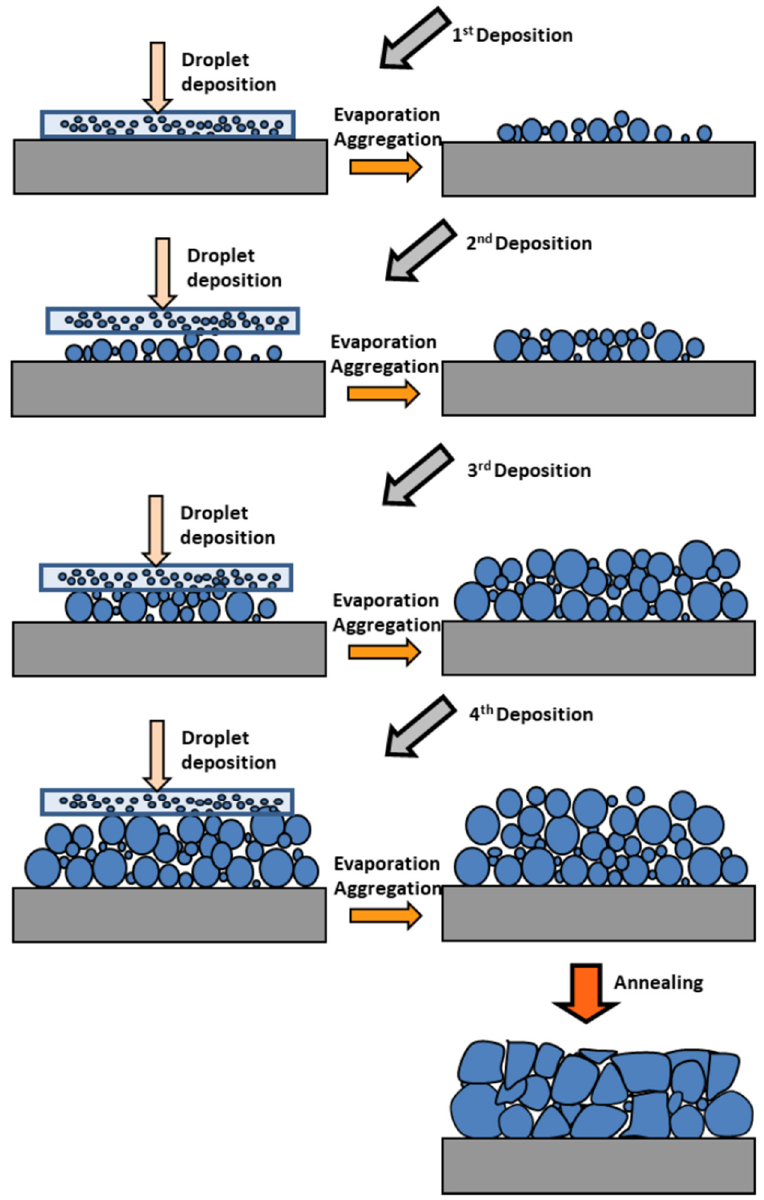
Figure 19. Growth diagram presenting the formation of aggregates during sol-gel spin-coating